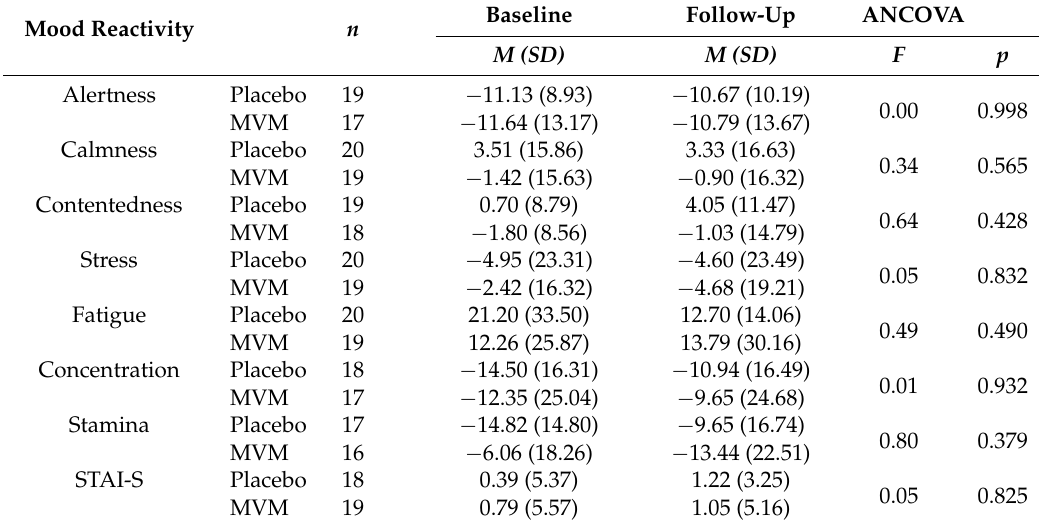
Table 5. Mood reactivity to cognitive assessment at baseline and follow-up for MVM and placebo treatment